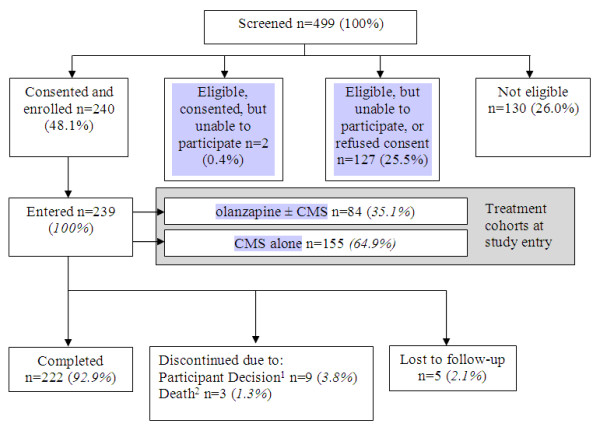
Participant Disposition.1 One participant withdrew consent after the first study visit; study entry results n = 239, post-study entry n = 238 (unless otherwise stated). 2 Two participants died due to natural causes, one from suicide.